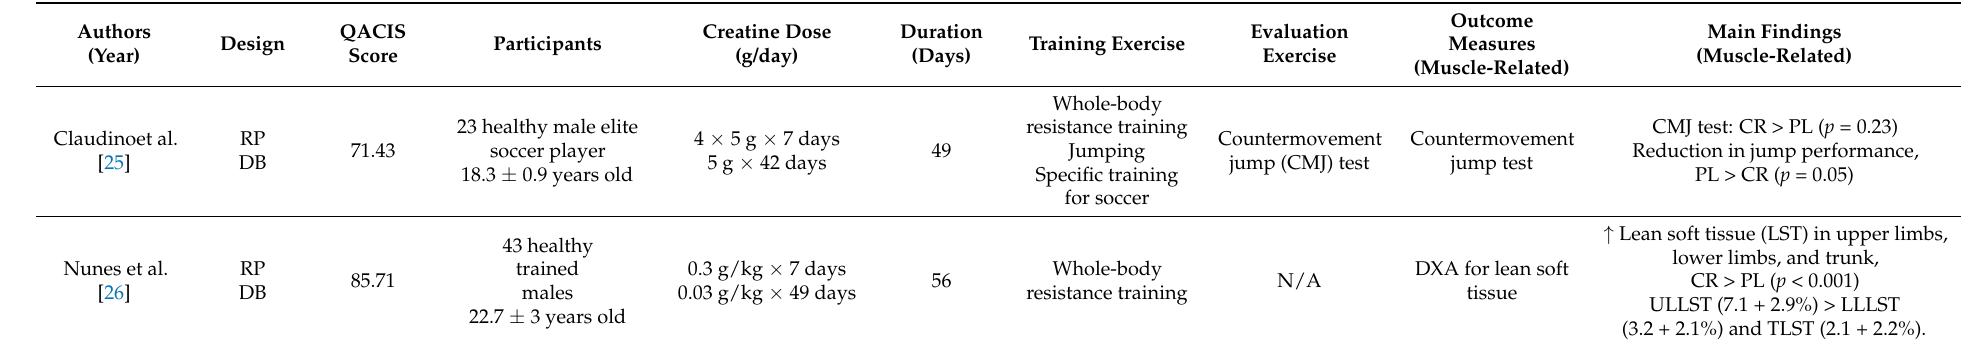
Table 2. Studies recruiting healthy trained young